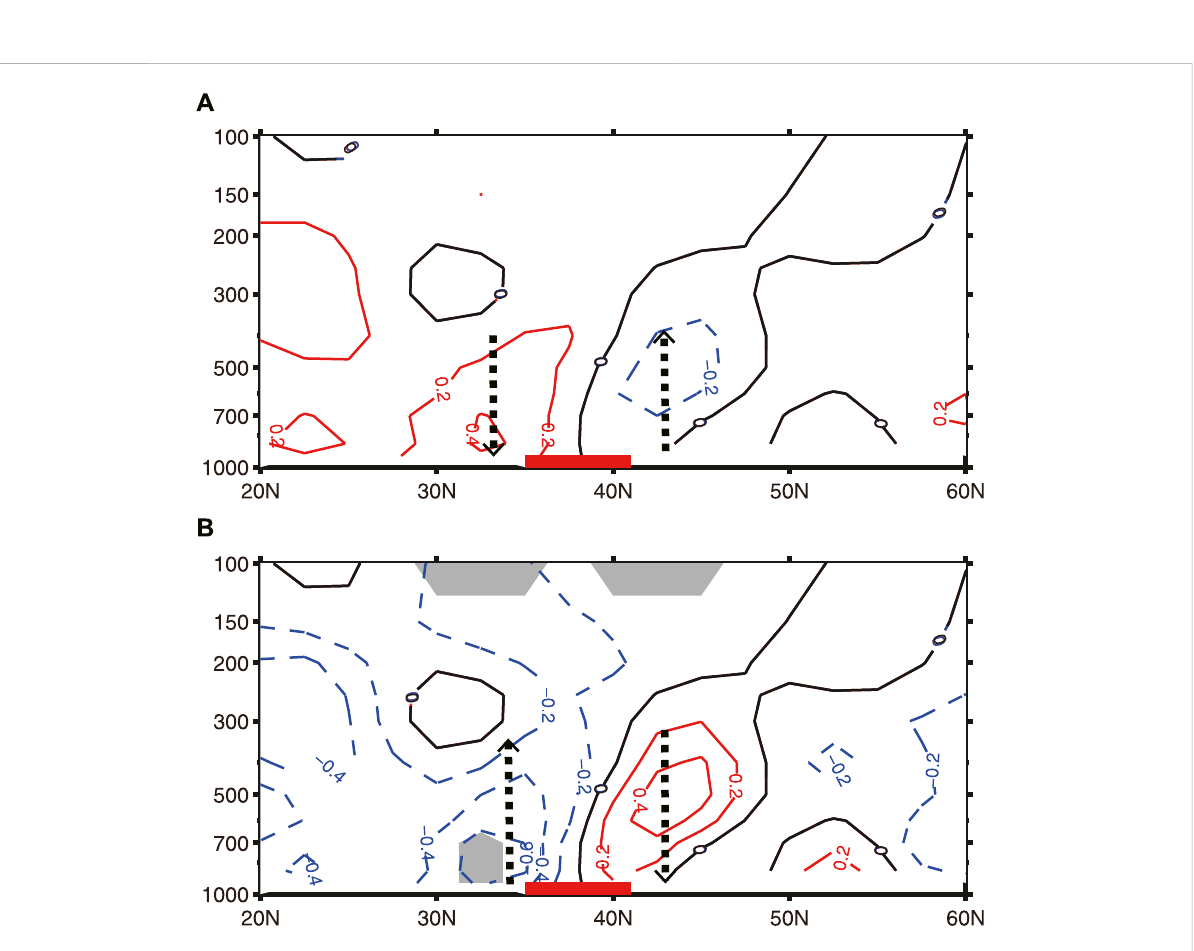
FIGURE 9 Latitude-height cross section of vertical velocity anomaly along 117.5 ° E in JA by (A) 1979 – 2005 mean minus 1979 – 2021 mean (unit: 10 − 2 Pa/s) and (B) 2006 – 2021meanminus1979 – 2021mean.Shadedareasarestatisticallysigni fi cantatthe95%con fi dencelevelaccordingtoStudent ’ s t -test. The red line shows the latitude range of North China. The black arrow line shows the abnormal vertical